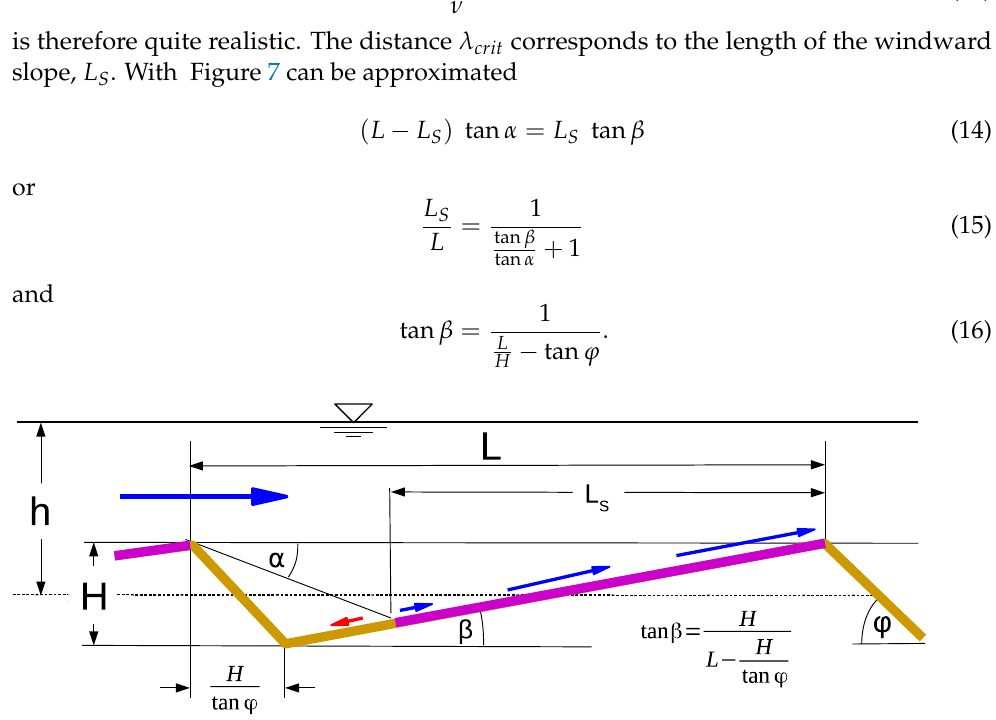
Figure 7. Definitions of the parameters used here to describe the ripple